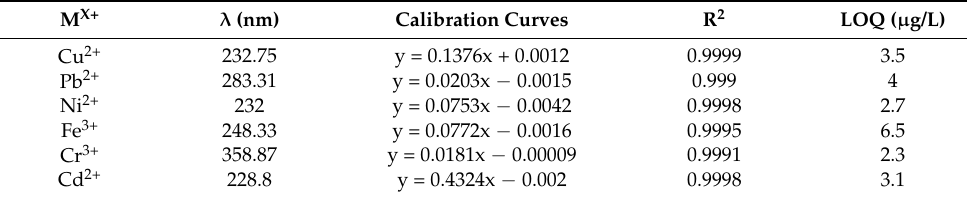
Table 2. Linearity parameters of AAS